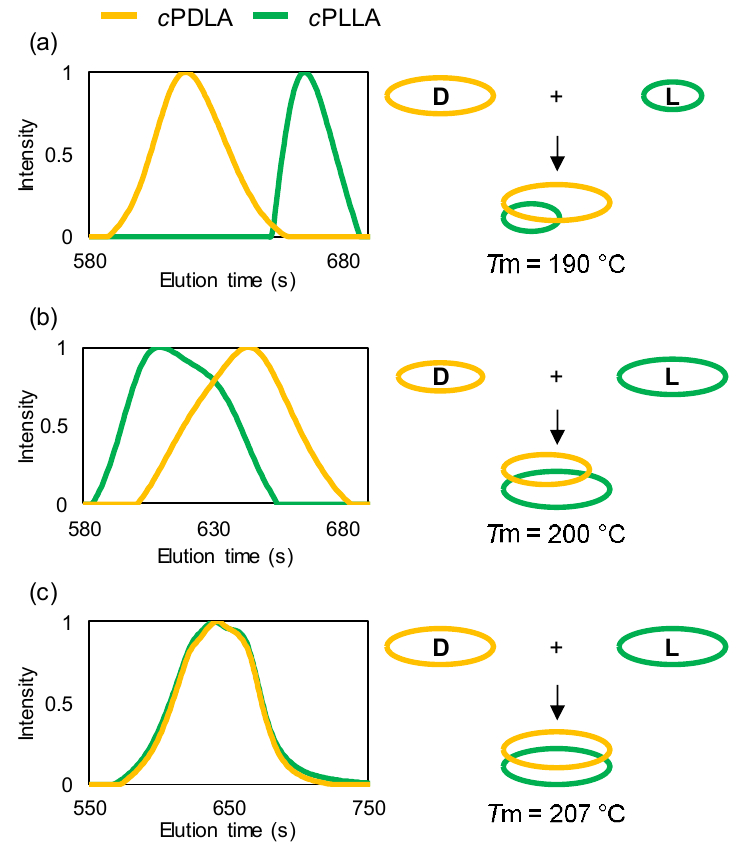
Figure 4. GPC traces of c PLA with different ring sizes and images of sc- c PLA.